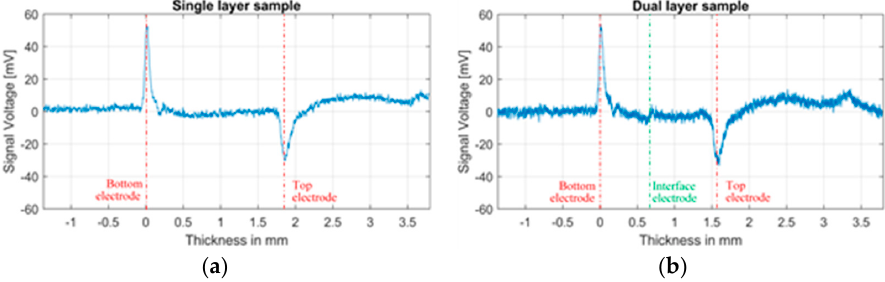
Figure 6. PEA signal without post-processing of 500 averaged measurements. ( a ) Single layer sample at 5.9 kV top electrode. ( b ) Dual layer sample at 2.14 kV interface and 5 kV top electrode.